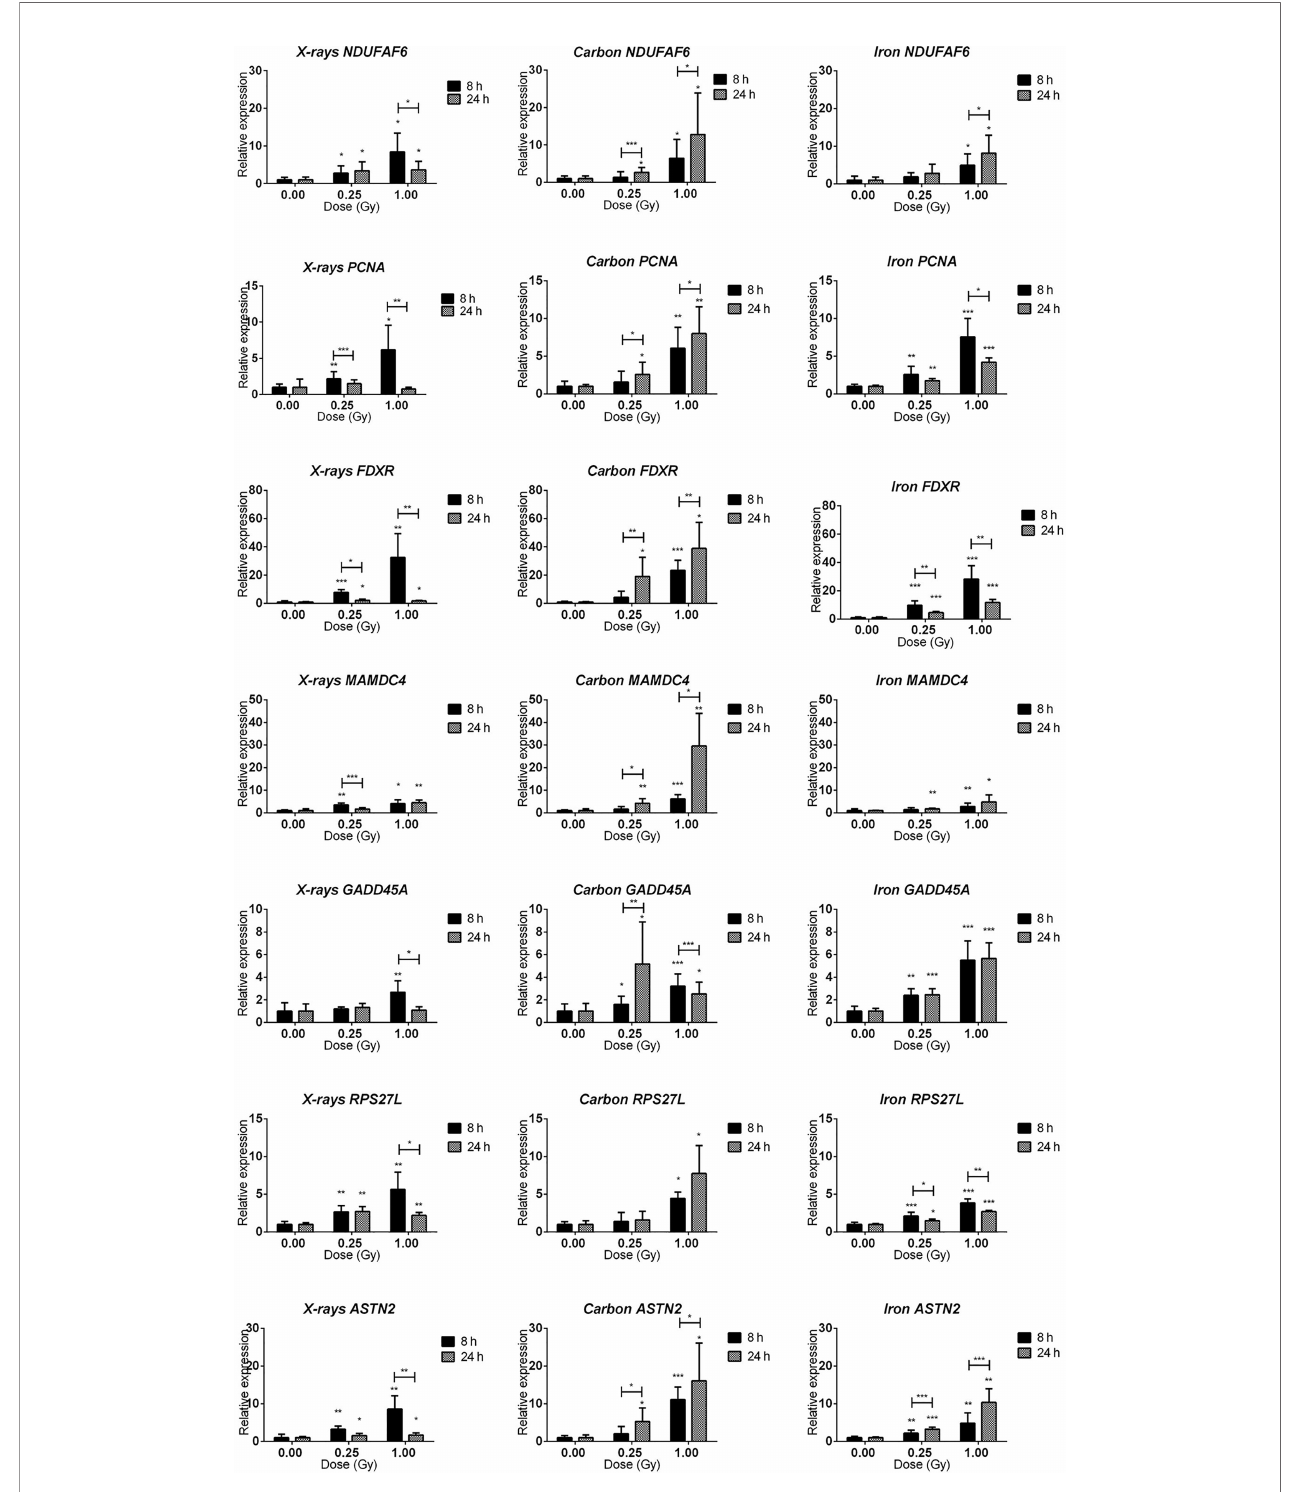
FIGURE 6 | qRT-PCR validation of the microarray results. qRT-PCR results for NDUFAF6, PCNA, FDXR, MAMDC4, GADD45A, RPS27L , and ASTN2 genes (shown in rows) at 8 and 24 h after irradiation with 0.25 and 1.00 Gy of X-rays, carbon or iron ions (shown in columns). Graphs represent mean of six biological replicates + standard deviation. Statistical comparison between samples irradiated with different doses at two different time points was performed using 2-way ANOVA with Bonferroni post-hoc test (*p < 0.05, **p < 0.005, ***p <